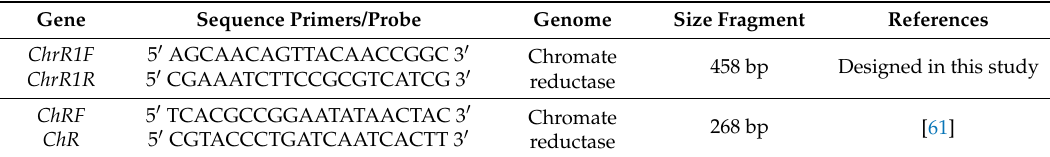
Table 2. Primers used for amplification of chromate